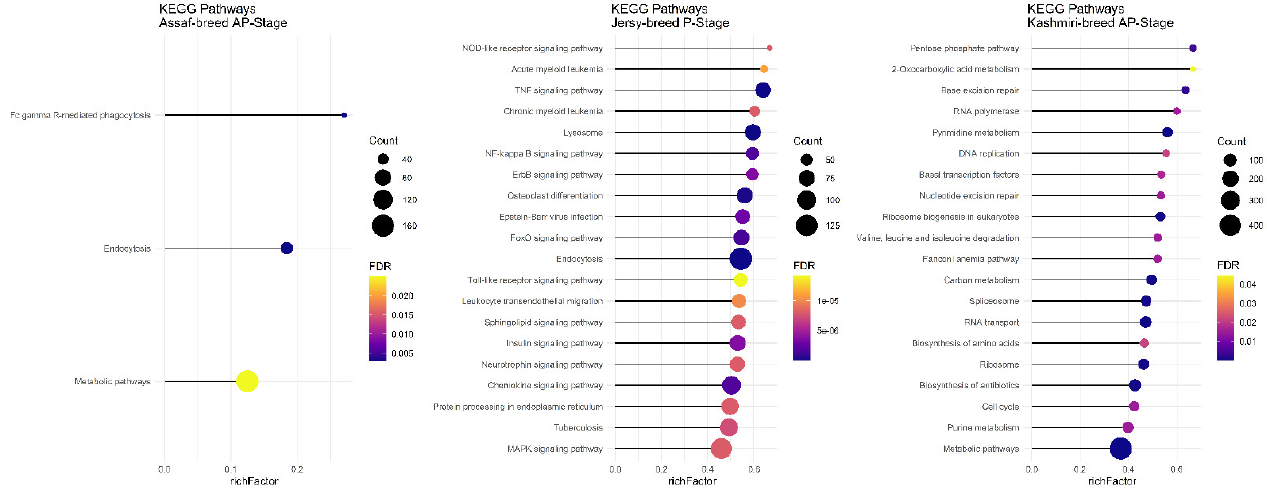
Figure 9. Functional enrichment analysis results of AP stage in Assaf, Jersy, and Kashmiri breeds. Since the significant KEGG pathways term is large, only 20 top significant terms are shown. The color and size of points indicate FDR and the number of genes associated with each term, respec- tively.